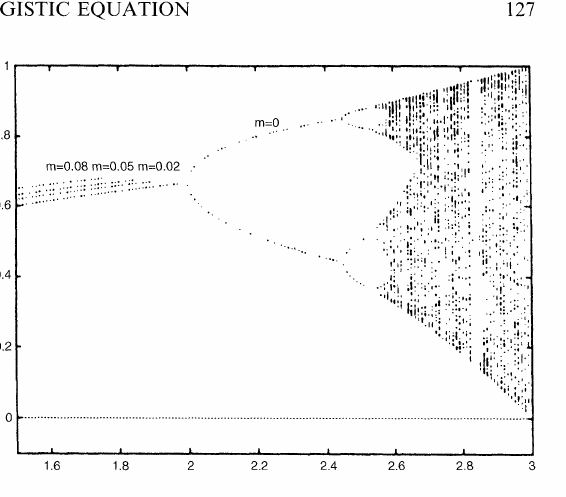
FIGURE Bifurcation diagram for free model with con- stant migration.